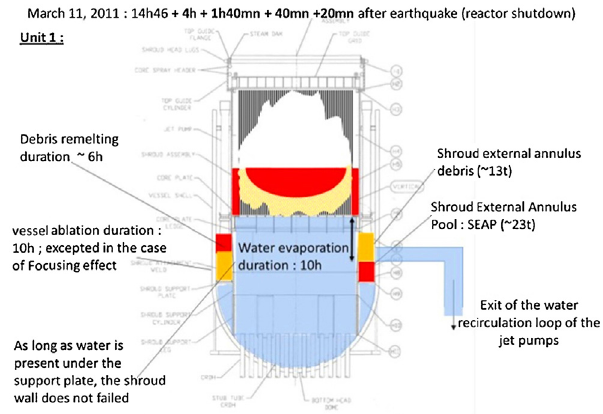
Fig. 5. Illustration of the corium relocation in the SEA: ∼ 6 h 40 after the reactor shutdown.